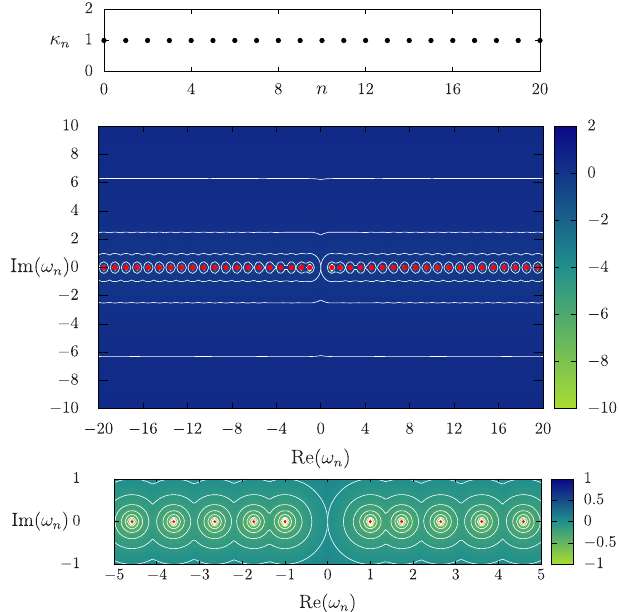
FIG. 6. Pseudospectrum and eigenvalue condition numbers of a self-adjoint operator (Pöschl-Teller potential with L 2 ¼ 0 ). Top 1 for ω panel: condition numbers, κ ( 0 ≤ n ≤ 20 ). Middle n ¼ n panel: pseudospectrum, “ flat ” pattern typical of a spectrally stable (normal) operator. Bottom panel: zoom near the spectrum, with concentric circles ( “ radius ϵ ” tubular regions around eigenvalues) characteristic of